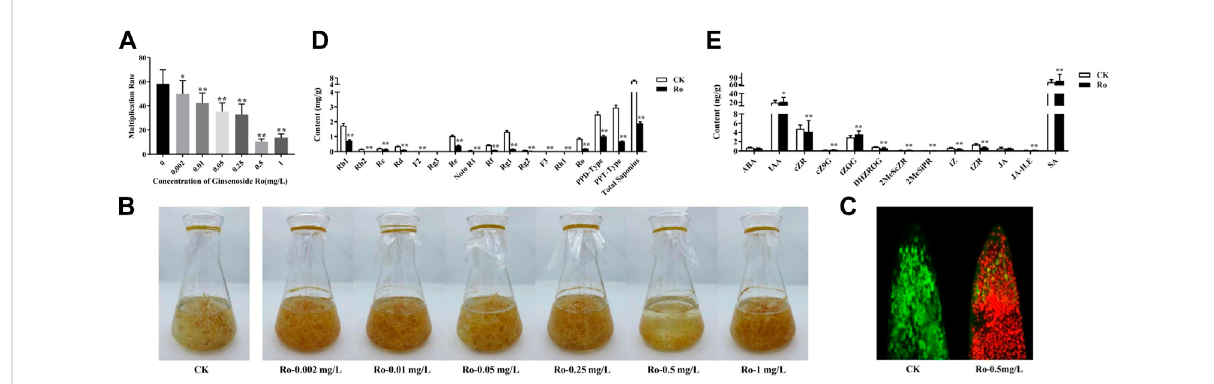
FIGURE 1 Effects of Ro on the appearance, ginsenoside content, and hormone content of the hairy roots of P. ginseng . Monthly multiplication rate of P. ginseng hairy roots induced by different concentrations of ginsenoside Ro (A) . Effects of different Ro concentrations on the appearance of ginseng hairyroots (B) .Ro-inducedroot-tipcellviabilitydifferencesinginsenghairy-rootinjury (C) .Changesinthecontentofginsenosides inthehairyroots of P. ginseng (D) . Absolute quantitative results of 13 hormones in the hairy roots of P. ginseng (E) . * indicates a signi fi cant correlation ( p < 0.05); ** indicates a signi fi cant correlation ( p <